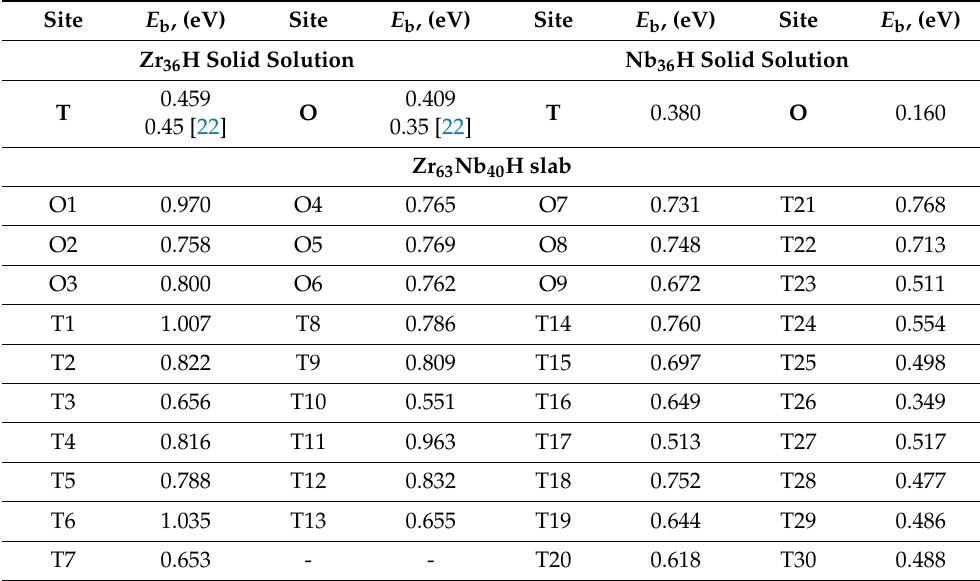
Table 2. The hydrogen binding energy in Zr 36 H and Nb 36 H solid solutions, Zr 63 Nb 40 H slab.